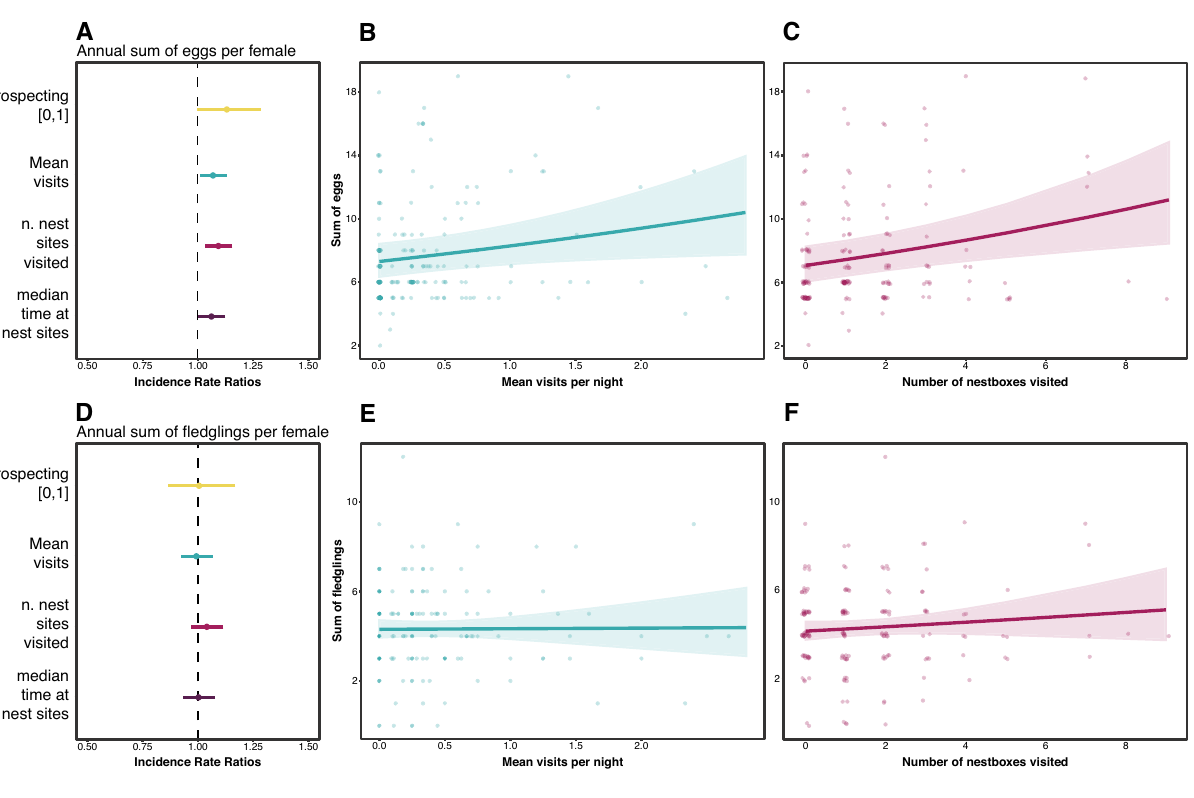
Figure 5. Set of univariate GLMM results (estimated coefficient with 95% confidence interval ranges) with prospecting parameters as predictors of annual sum of eggs ( A ) and annual sum of fledglings ( D ) produced by female barn owls. ( B,C,E,F ) Panels represent the relationship (regression line and 95% confidence interval area) between two prospecting parameters and the annual sum of eggs and fledglings. Colours are different for each prospecting variable and used to link the scatterplots to the effect